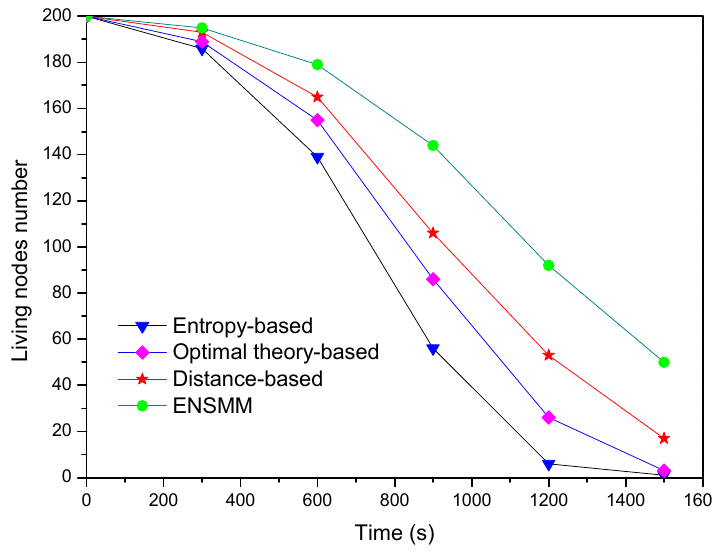
Figure 13. The average energy consumption in tracking stage.